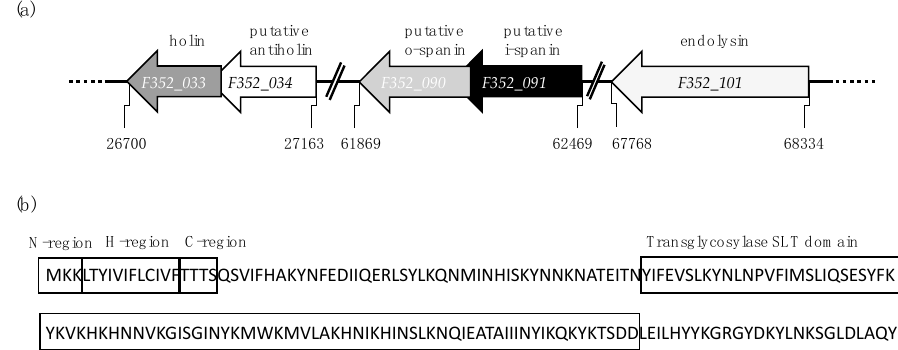
Figure 1. Illustration of lytic genes predicted in Fletchervirus phage F352. ( a ) Relative positions of predicted lytic genes in the genome of phage F352. ( b ) Secondary structure of phage F352 endolysin. The endolysin is predicted to possess a signal peptide (with N, H and C regions) that is located distantly from the catalytic soluble transglycosylase (SLT) domain.